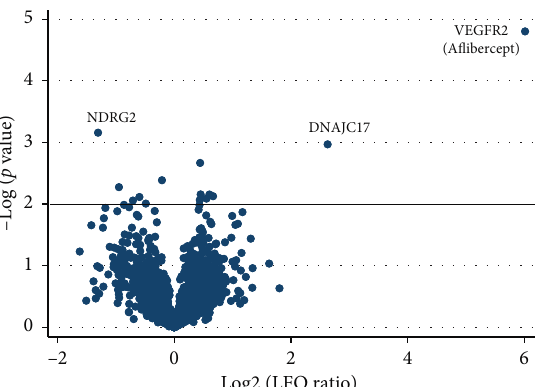
Figure 2: Volcano plot. Quantitative data from label-free quantification liquid chromatography tandem mass spectrometry (LFQ LC-MS/ MS) were measured as label-free quantification (LFQ) values. Log2 LFQ ratios (aflibercept/NaCl) are plotted on the x -axis. On the y -axis, −